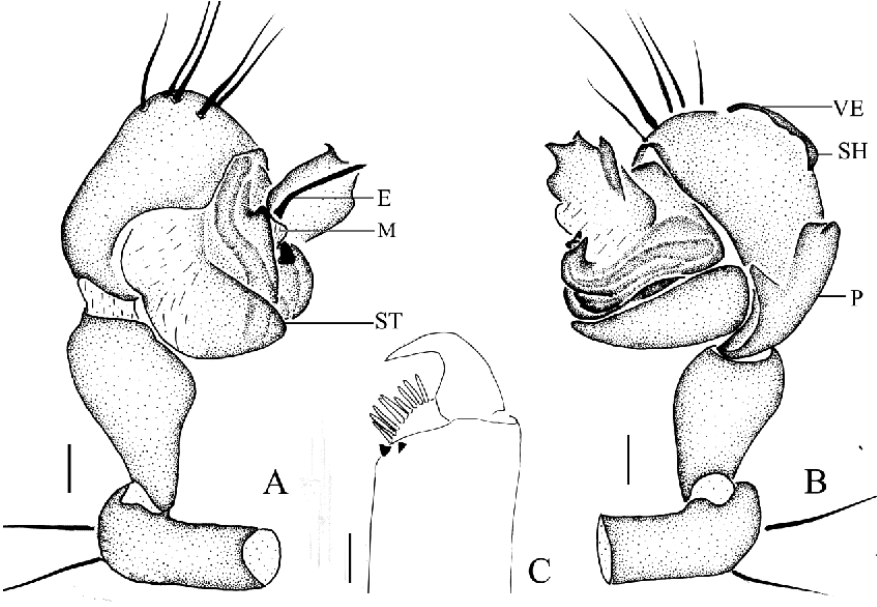
Figure 2. Mimetus echinatus Wang, 1990, one of the male. A palp, prolateral view B palp, retrolateral view C left chelicera, ventral view. Scale bars: A–B , 0.2; C ,